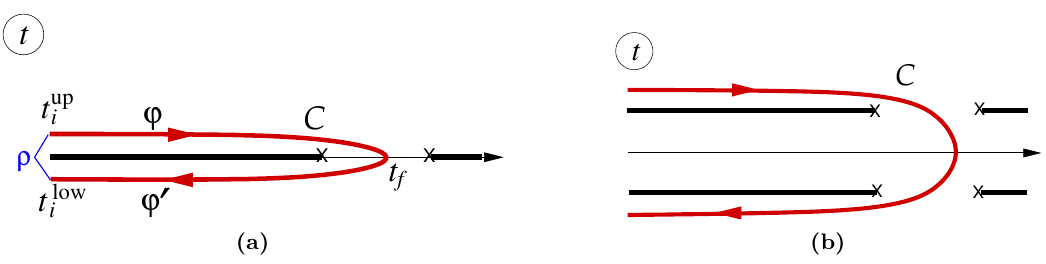
Figure 4. (a) Contour C in the complex time plane for the calculation of the false vacuum decay probability in the in-in formalism. It supports the bounce solution in theories with unbounded scalar potential. Crosses show the branch-point singularities of the bounce. (b) Singularities of the bounce in theories with scalar potential bounded from below. The contour C must be deformed to encircle a pair of branch